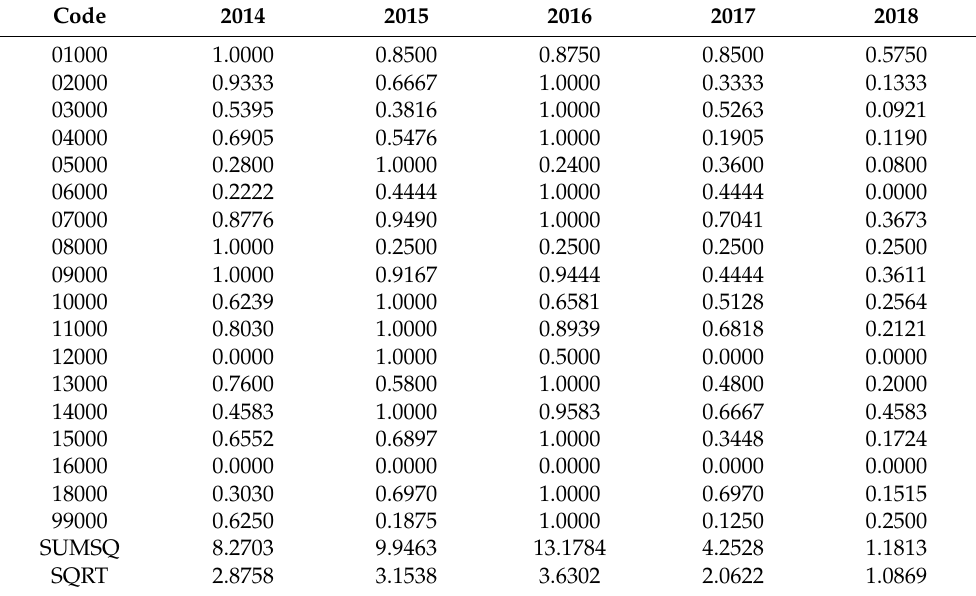
Table A8. The first step of TOPSIS analysis is adopted for the deficiency data of Taiwanese